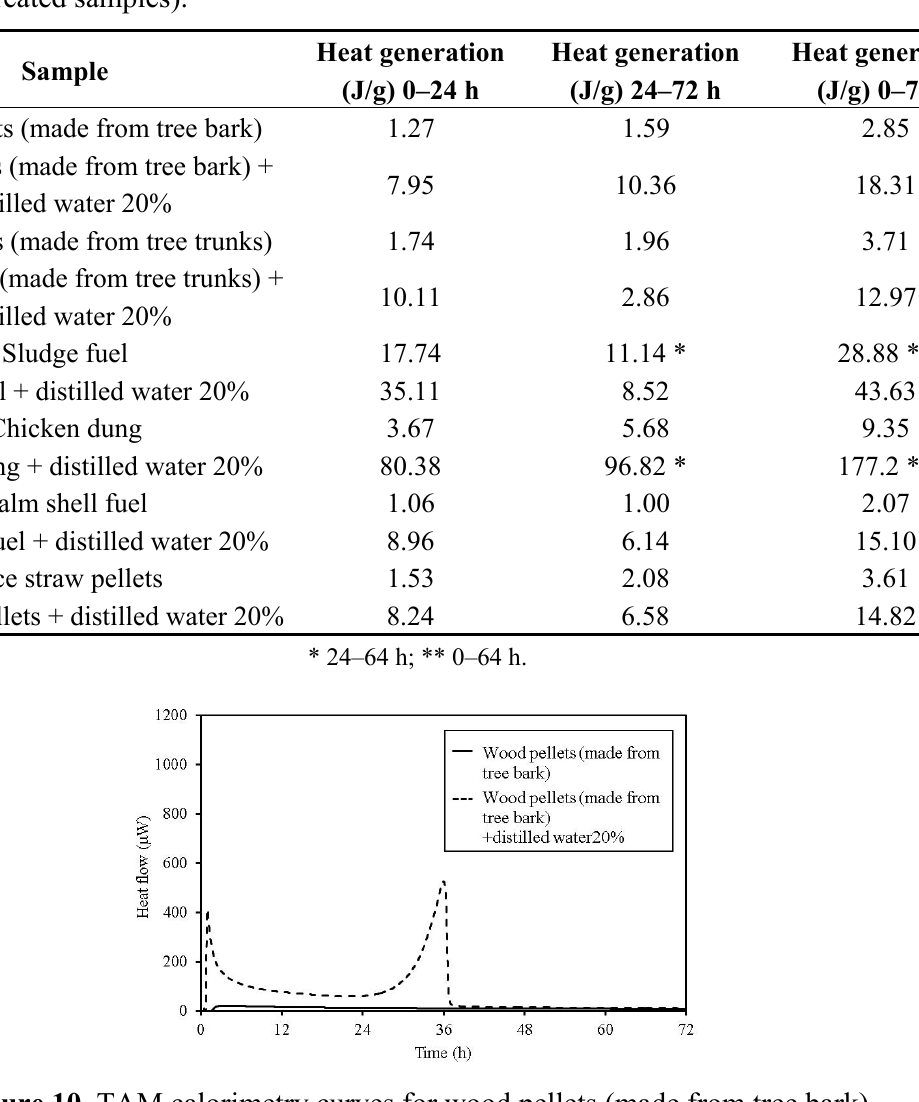
Figure 10. TAM calorimetry curves for wood pellets (made from tree